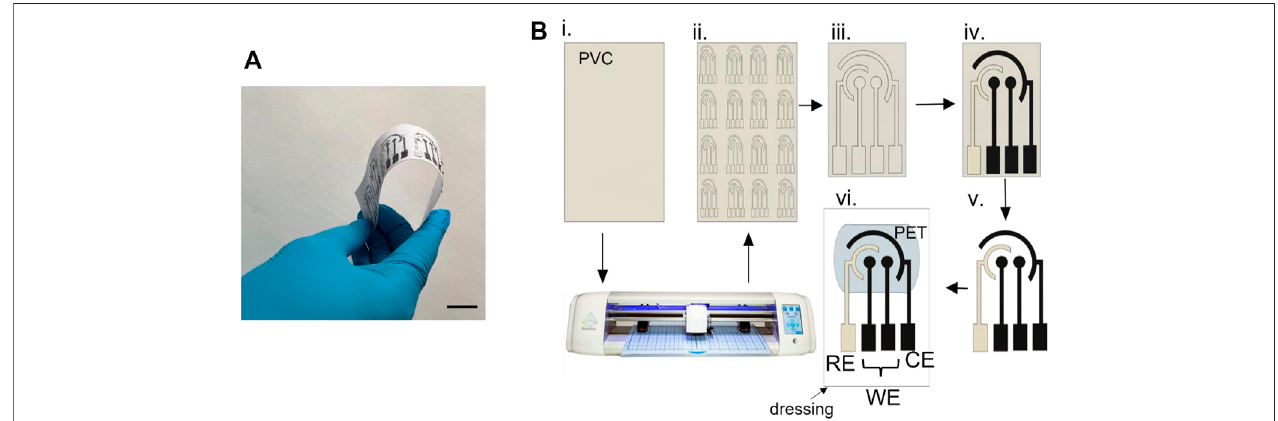
FIGURE 3 | (A) Cross-sectional view of the electrochemical sensor fabricated on a wound dressing pad. The wound fl uid diffuses to the sensor surface through a porous gauge. Inset of (A) shows the SEM images of the 0.5% (w/v) AuNP decorated MWCNT coating on the two working electrodes. The scale bar corresponds to 100 nm. (B) SEMimagesshowingthemorphologyoffour(0.1,0.5,1.0and2.0%)differentdispersionsofAuNPdecoratedMWCNTcoating.Allthescalebarsrepresent 1 μ m. (C) Characterization of the AuNP-MWCNT coating using FTIR.